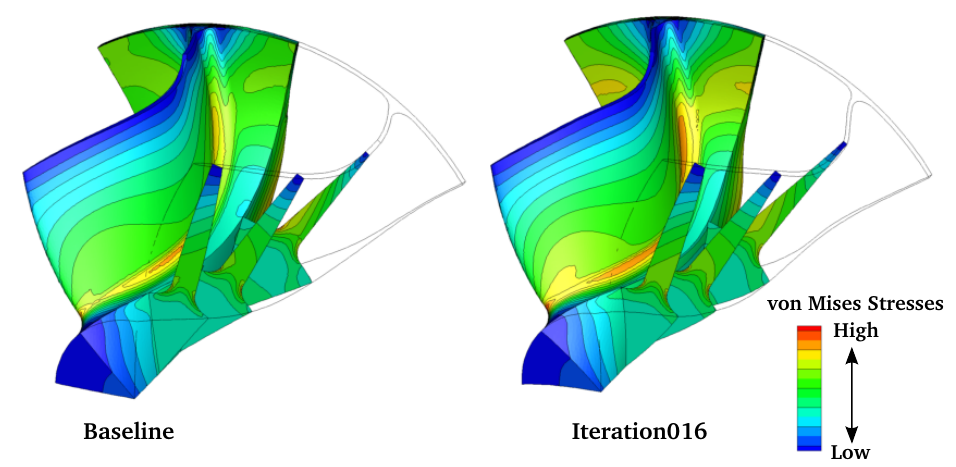
Figure 17. Comparison of von Mises stresses in the baseline and the optimized turbine wheel